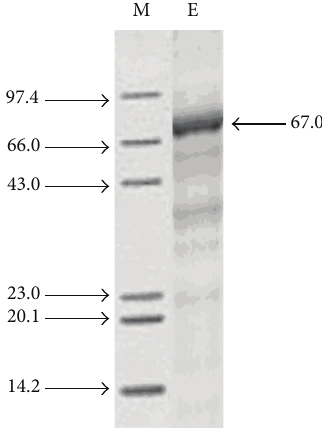
Figure 13: Photographic representation of the SDS-PAGE of amy- lase of Bacillus tequilensis . Lane 1: marker proteins; lane 2: enzyme supernatant (amylase). Molecular weights were presented in the form of